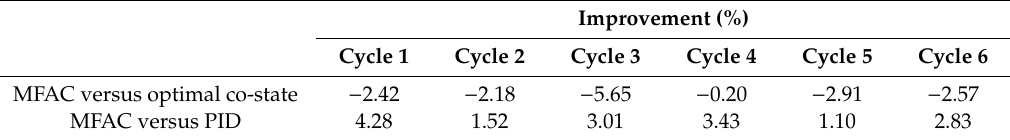
Table 5. Fuel consumption improvement of the